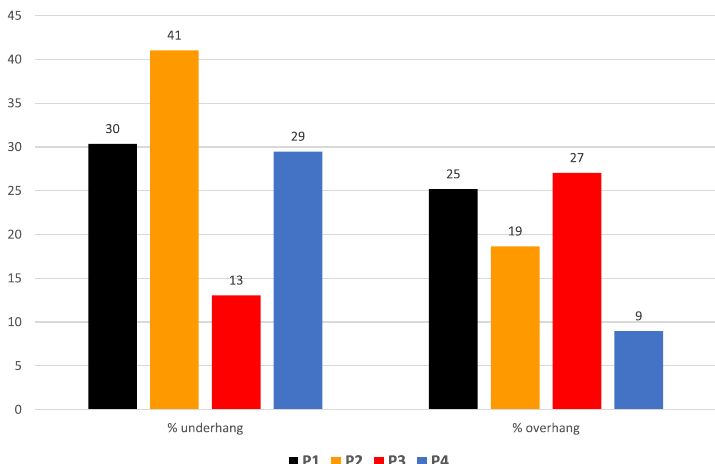
Fig. 8 Depicts the percentage of underhang (on the left) and overhang (on the right) for each OTS femoral implant considered in this